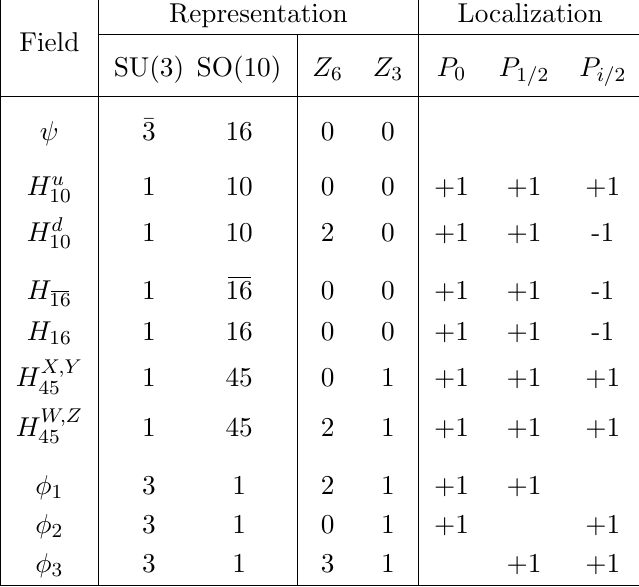
Table 1 . The simple (cid:12)eld content used in constructing the model, including matter, Higgs and (cid:13)avon